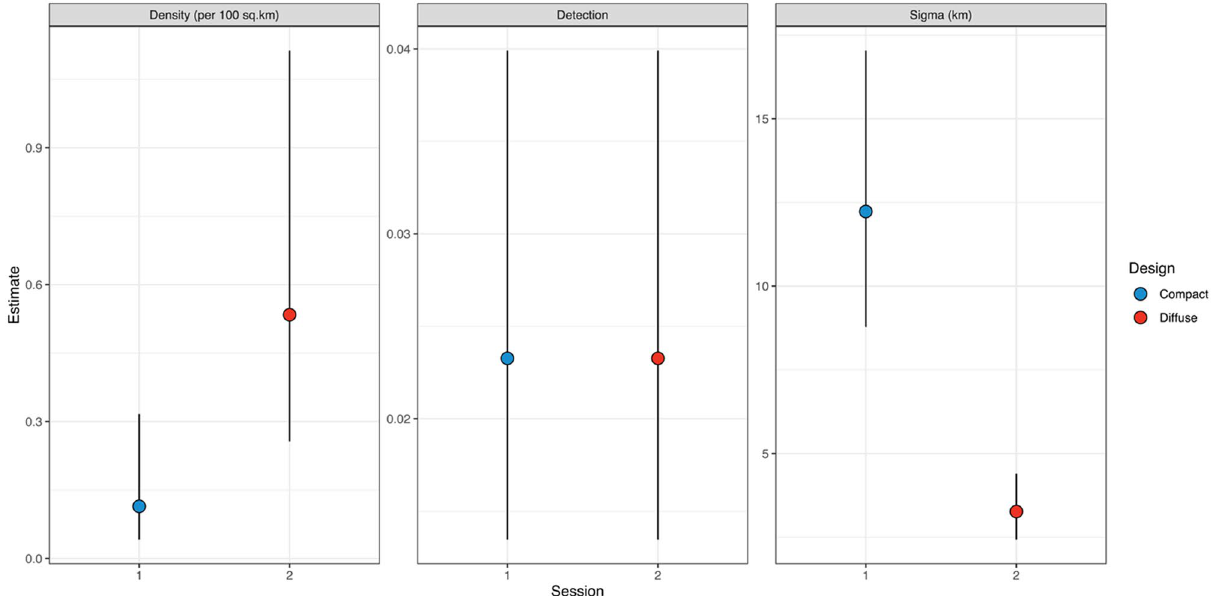
Figure 2. Effect of design on SCR parameter estimates in camera trap study of snow leopards in Hunza-Nagar districts, Gilgit-Baltistan, Pakistan. Bars indicate 95% Confidence